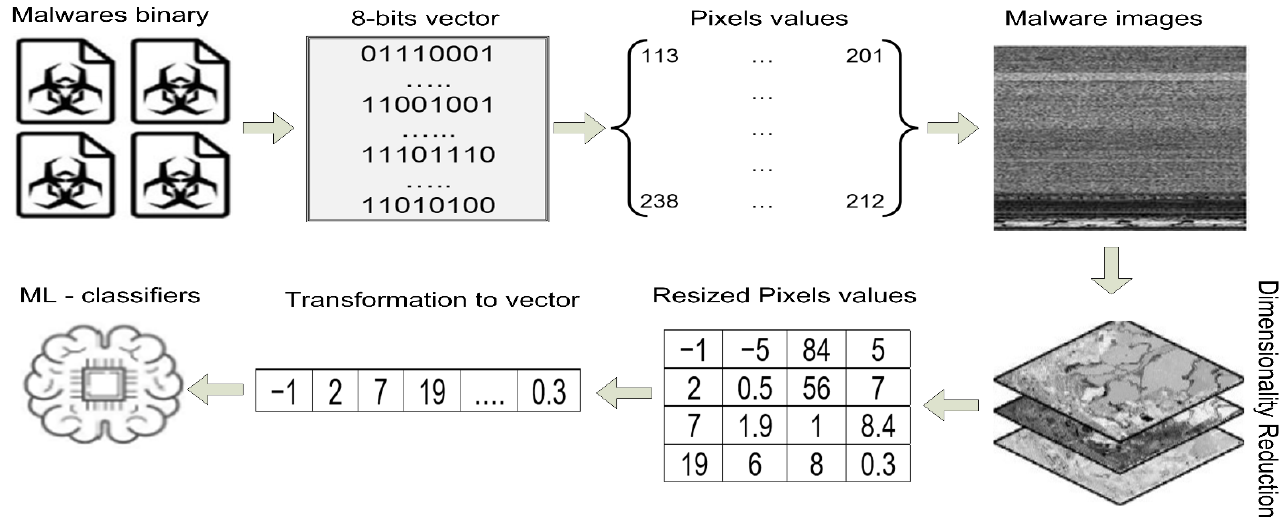
Figure 9. The transformation of malware images from binary to feature vector.